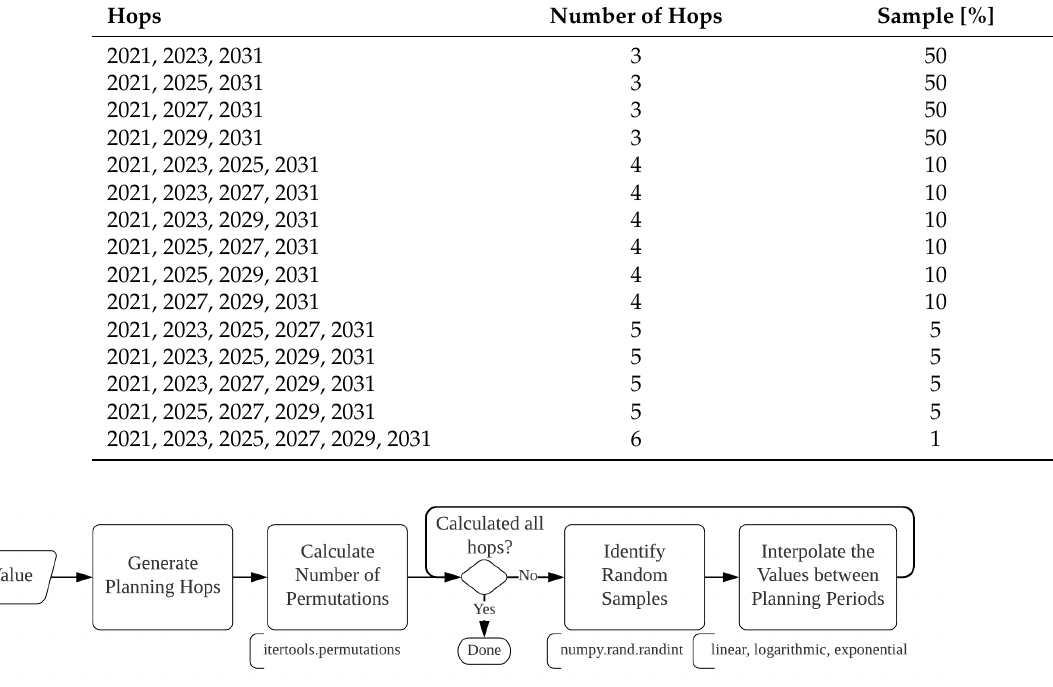
Figure 8. Monte Carlo random sampling for the middle